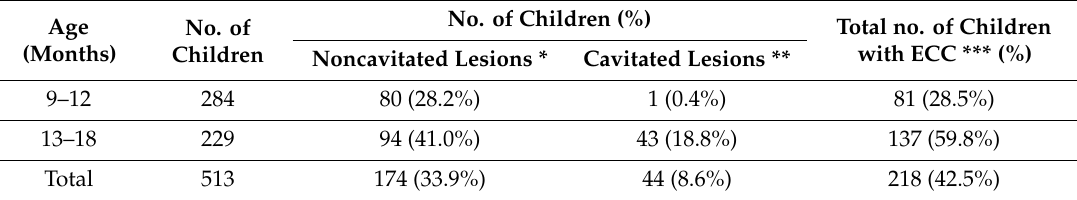
Table 1. Prevalence of early childhood caries (ECC) according to the age of the children. Age